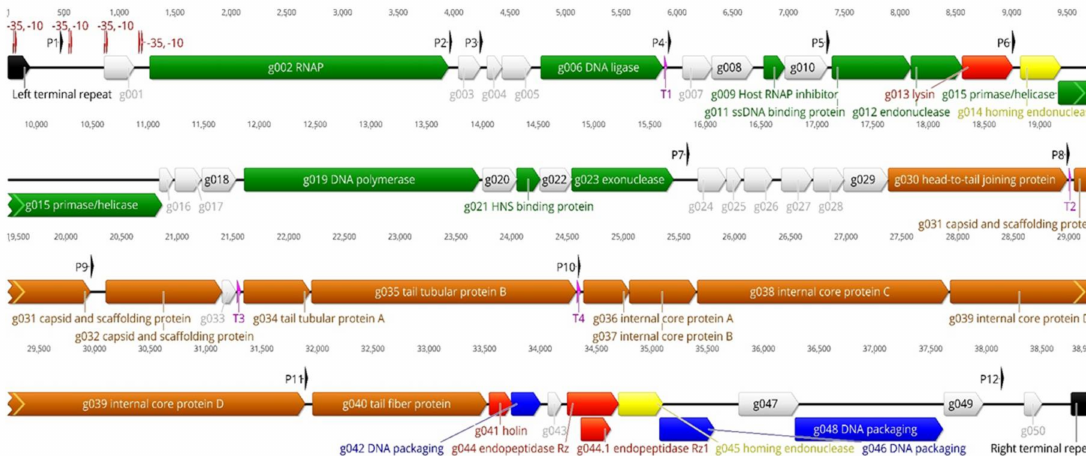
Figure 5. The genomic map of fPS-7. The predicted genes are arranged in the direction of transcription shown by different colored arrows. Genes involved in nucleotide metabolism, DNA replication, recombination or repair are shown in green. Genes involved in morphogenesis and virion structures are depicted in brown. Genes involved in DNA packaging and lysis, are shown in blue and red, respectively. Genes coding for hypothetical proteins or conserved phage proteins of unknown function are shown in light grey. Homing endonucleases are shown in yellow. Direct terminal repeats (DTRs) are shown in black. On top of the genome, the host RNA polymerase (RNAP)-dependent promoters are shown with red double-arrows labelled with − 35 and − 10, and the phage RNAP-dependent promoters with black arrows labelled from P1 to P12. Terminators are shown along the genome as purple triangles and labelled from T1 to T4. The genetic map was created using the Geneious